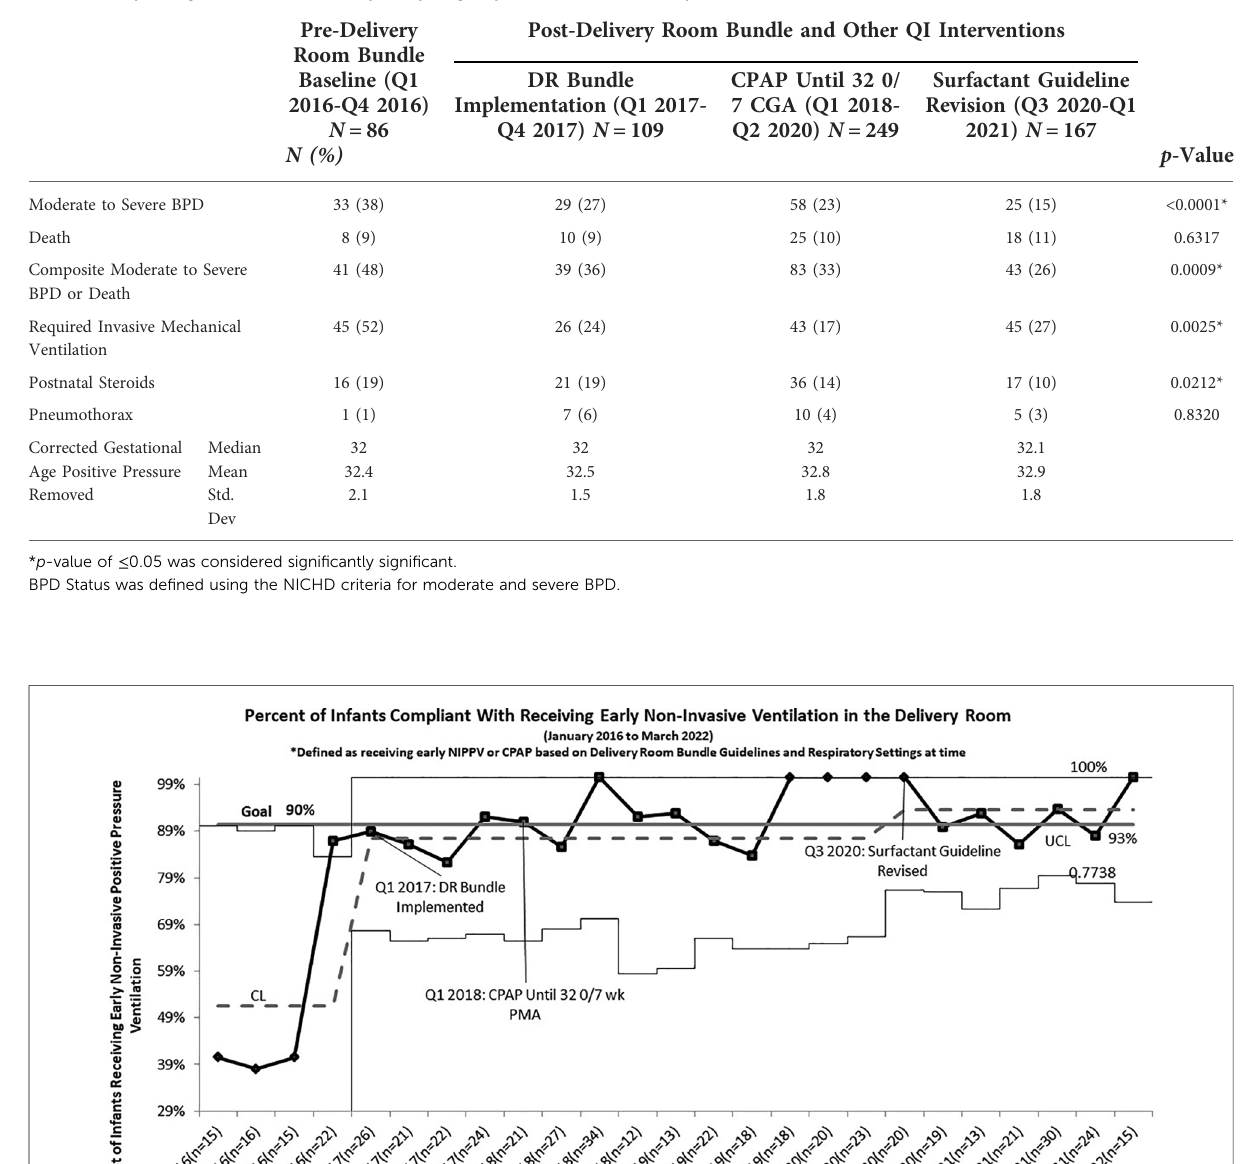
TABLE 2 Respiratory outcomes Pre- and post-quality improvement initiative implementation.